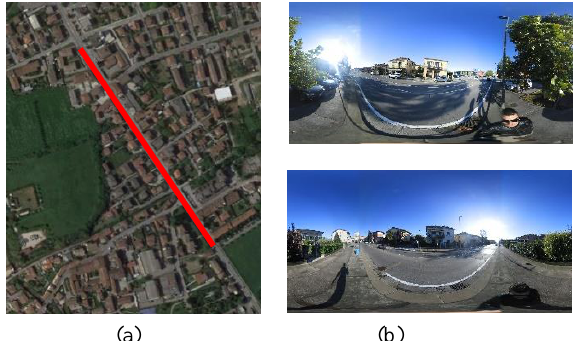
Figure 2. The route portion considered for the experiments (Via San Polo, Brescia) and panoramic images. (a) Trajectory estimated from immersive video (red line). (b) Two frame extract from immersive video along the trajectory